Question: Write a caption explaining this figure to a reader.
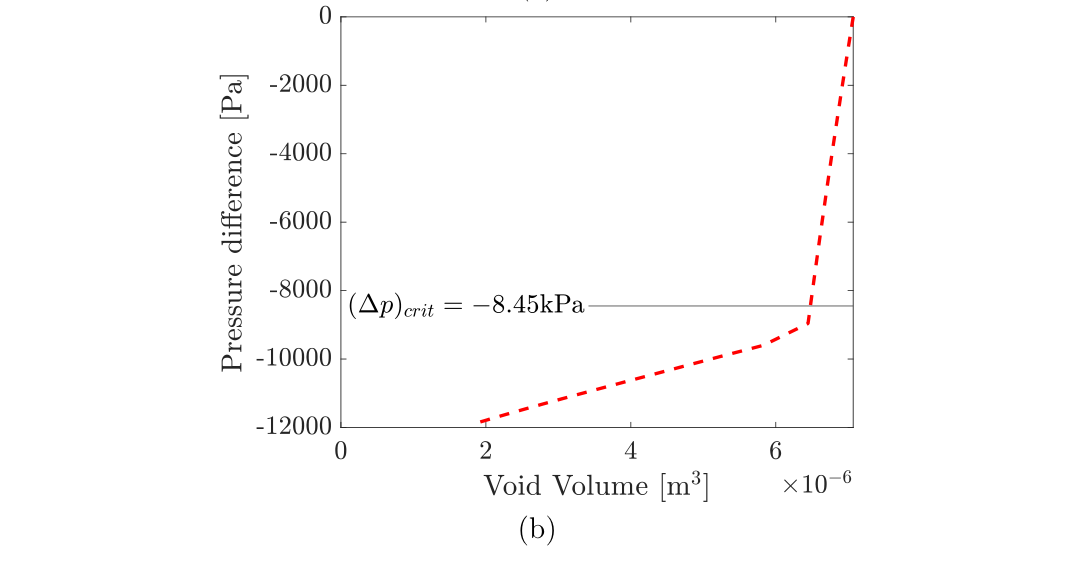
Answer: Simulation and experimental data of a pneumatically actuated sample of a pattern- forming metamaterial. (a) Comparison of the deformed states from simulation and experiment for various levels of internal pressure loading. (b) A corresponding pressure-volume diagram, with an apparent point of internal instability. The horizontal line highlights the experimentally determined buckling pressure of (∆p)crit = −8.45 kPa.